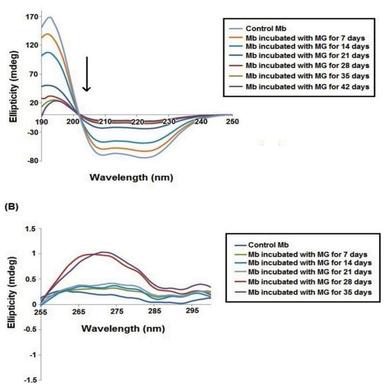
CD study. (A) Far-UV CD spectra of control Mb ( ) and Mb incubated with MG for 7 days ( ), 14 days ( ), 21 days ( ), 28 days ( ), 35 days ( ) and 42 days ( ) recorded in the 190–250 nm range. (B) Near-UV CD spectra of control Mb ( ) and Mb incubated with MG for 7 days ( ), 14 days ( ), 21 days ( ), 28 days ( ) and 35 days ( ) recorded in the 255–300 nm range. Protein concentration was adjusted to 5 μM for recording the spectra. (For interpretation of the references to color in this figure legend, the reader